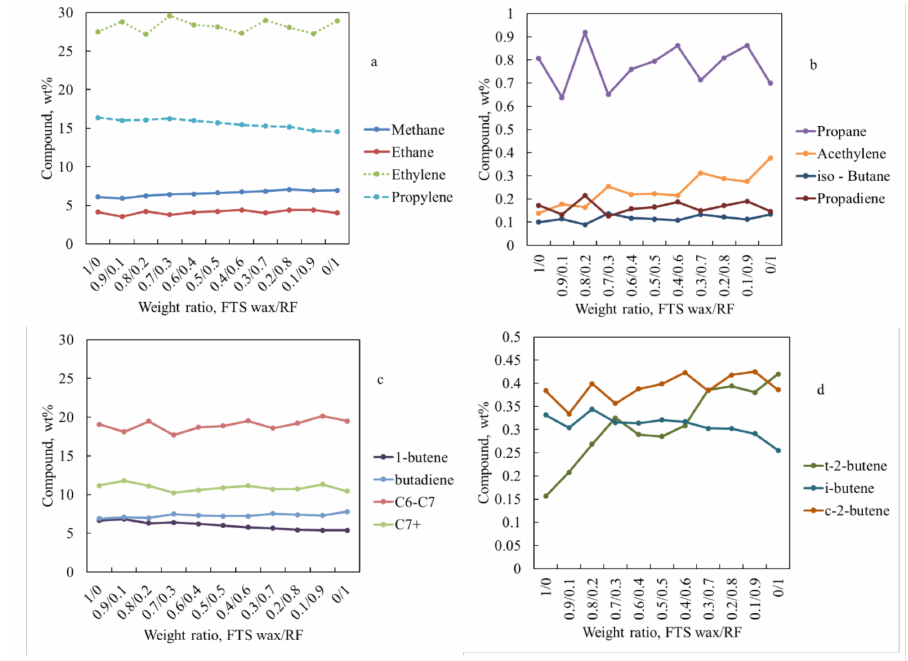
Figure 4. Product composition for pyrolysis tests containing different FTS waxes/RF